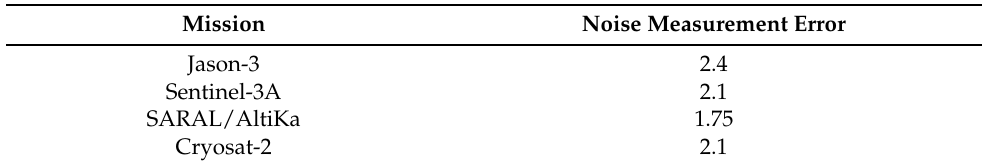
Table 1. Mean 1 Hz noise measurement observed for the different altimeters on along-track (L3) DUACS products in the Mediterranean Sea. Noise for raw SLA is indicated in cm rms.